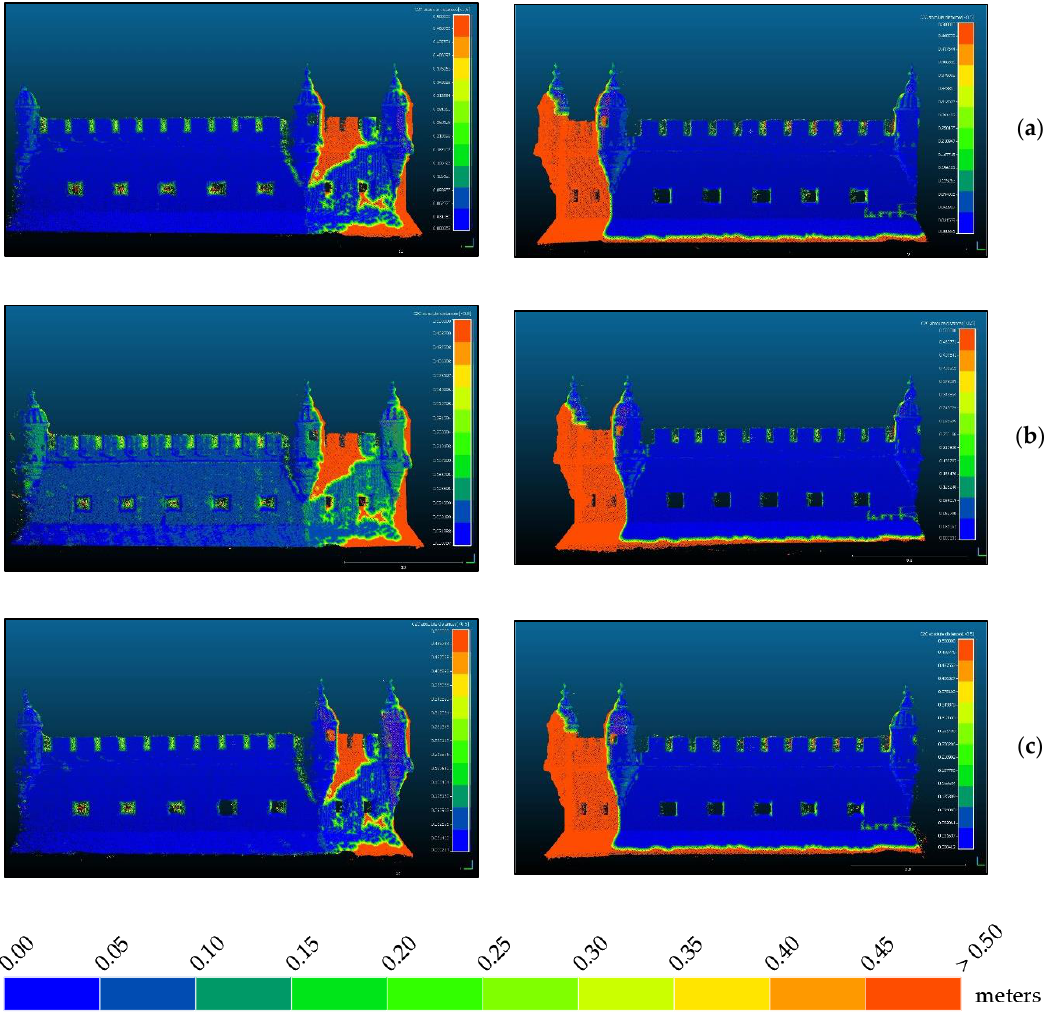
Figure 16. Differences between photogrammetric and TLS point clouds in common areas: (left) West bulwark façade; (right) East bulwark façade. ( a ) ICP; ( b ) Total station points; ( c ) TLS points. (Bottom) enlarged color scale.